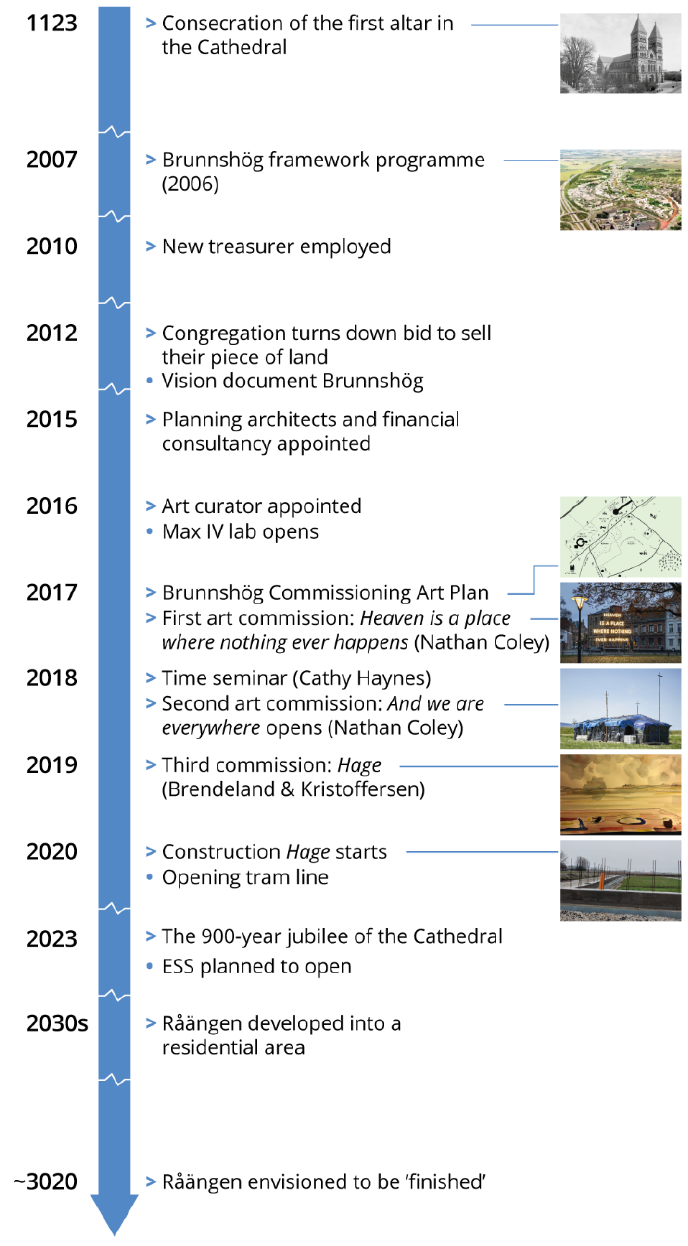
Figure 2. Timeline of the Råängen